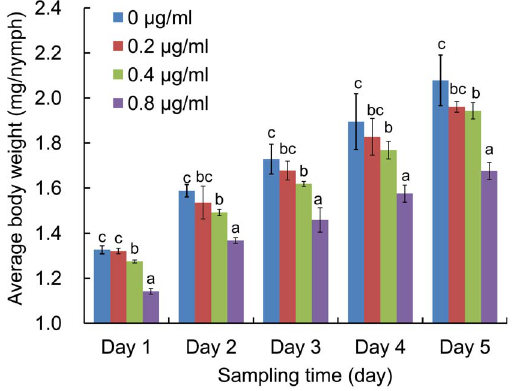
Figure 6. Effect of nlgst1-1 dsRNA on the body weight grain of BPH nymphs. BPH nymphs that had been pre-fed on artificial diets containing the indicated concentrations of nlgst1-1 dsRNA for 3 days were transferred to cultivar TN1 (BPH susceptible rice variety with low gramine content) rice plants to continually be reared for an additional 5 days in the controlled growth chambers (90% r.h., 28 u C, 14 hr photoperiod). The body weight of each BPH nymph was weighed every day during this 5-day period of rearing on the rice plants. The average weight of nlgst1-1 dsRNA pre-fed BPHs was plotted as a function of days post rearing on the rice plants. All treatments were performed in triplicate groups with at least 10 nymphs in each group. The experiments were repeated at least five times. Data represent the means 6 SD from at least five independent experiments. Bars with different letters indicate significance at P ,